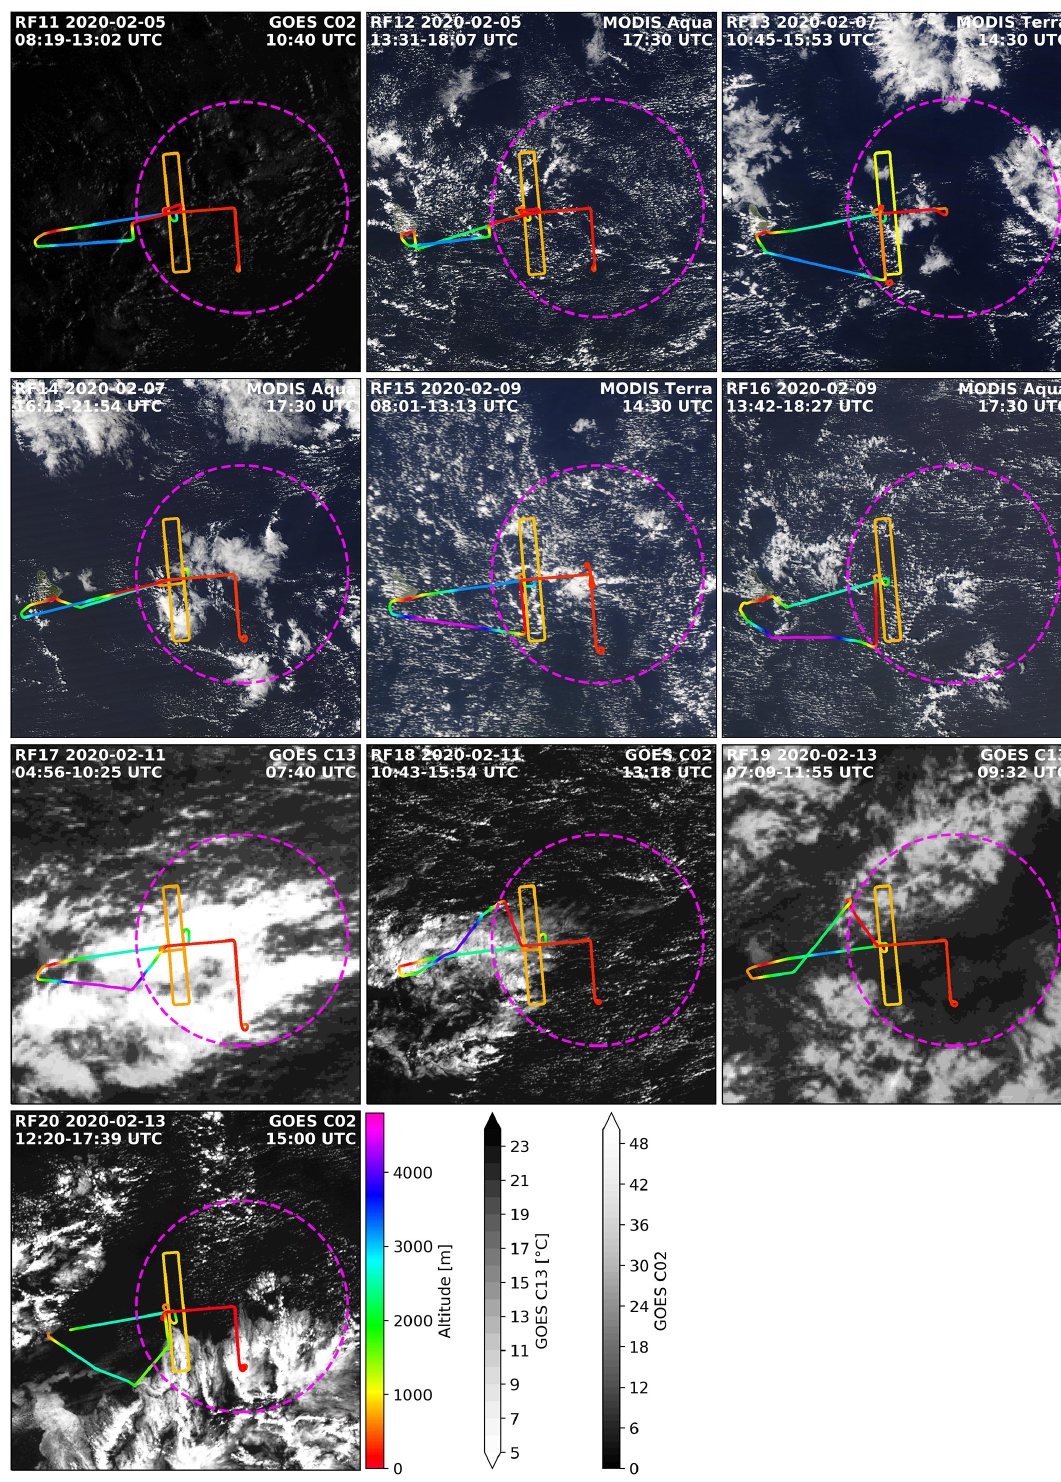
Figure C2. Longitude–latitude trajectories of the ATR colored by the flight altitude. For repetitive flight patterns (e.g., the rectangles), only the last repetition is visible due to the overlap. The dashed circle shows the EUREC 4 A circle along which HALO was flying. The ATR tracks are shown on top of a satellite snapshot of the domain (11.8–14.8 ◦ N, 57–60 ◦ W) derived from either MODIS Terra/Aqua images (when available during the flight) or GOES-16 (using either the C02 (visible) or C13 (infrared) channel) at about mid-flight